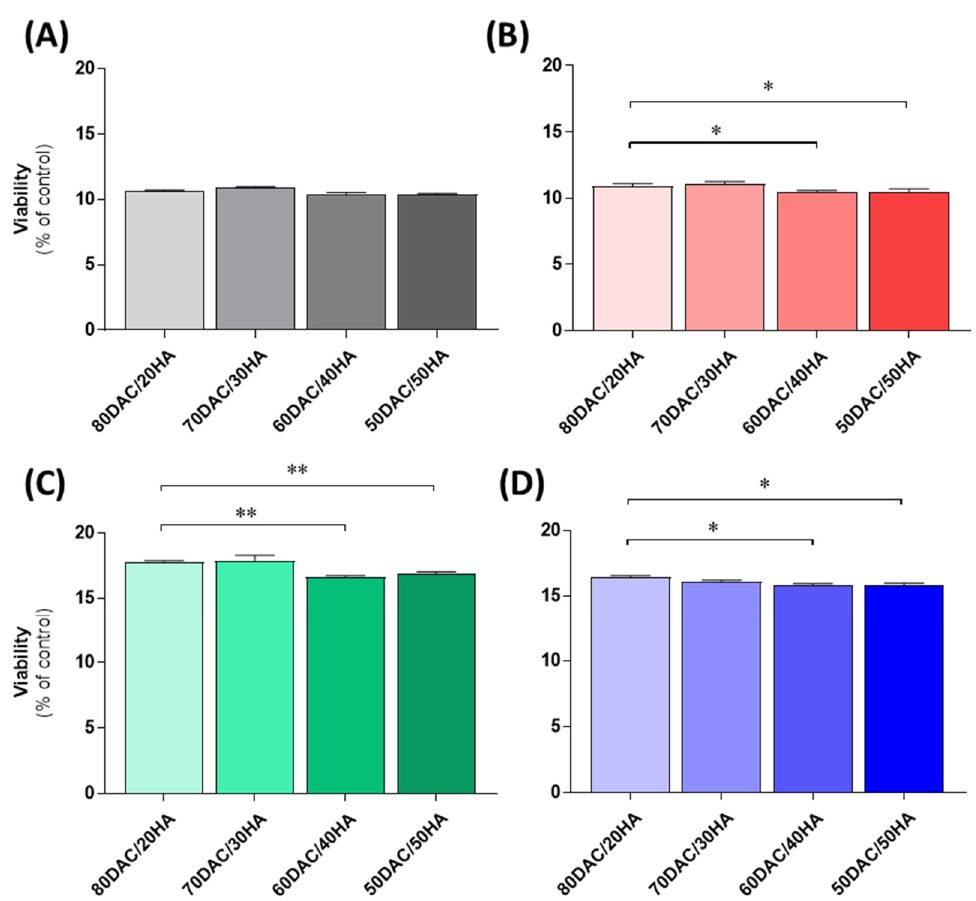
Figure 4. Human epidermal keratinocytes (NHEK) ( A ), dermal fibroblasts (NHDF) ( B ), as well as human melanoma cells (A375, ( C ) and G-361, ( D )) were seeded on resultant scaffolds, cultured for 96 h, and viability was assessed using the MTT viability assay as described in the Materials and Methods. Data are presented as mean + S.D. ( n = 6). Statistically significant differences were indicated accordingly as * p < 0.05, ** p < 0.01.